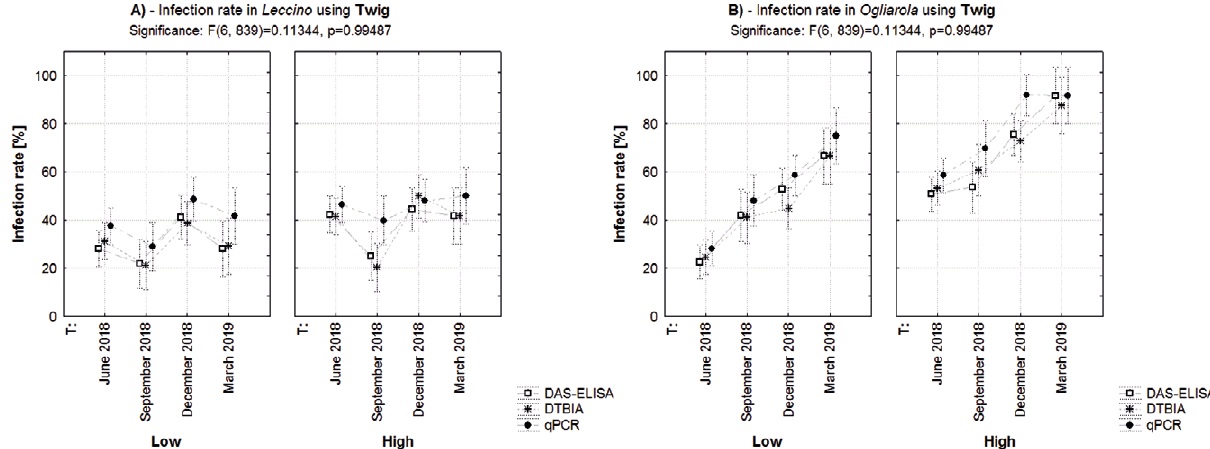
Figure 6. Mean infection rates in olive trees of ‘Leccino’ (A) and ‘Ogliarola salentina’ (B) assessed using the host twigs and three diff erent diagnostic assays at four diff erent sampling times